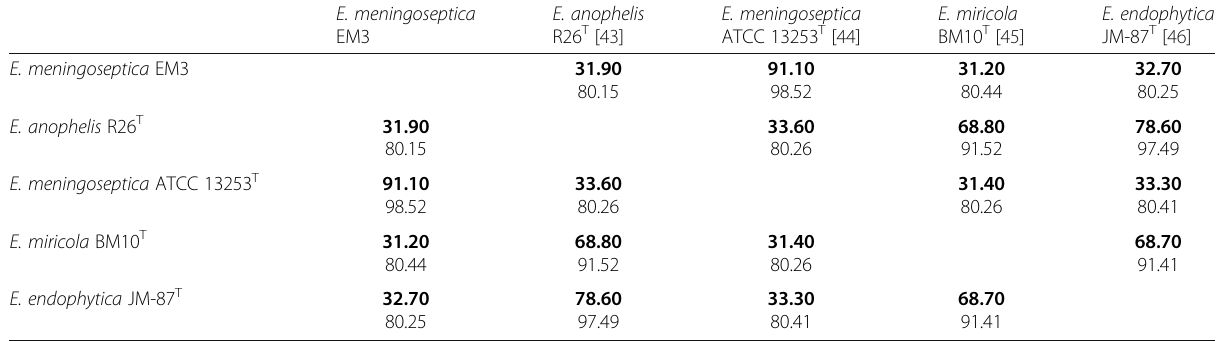
Table 2 Percentage of in silico DNA-DNA hybridization (DDH) a and average nucleotide identities (ANI) b among the selected Elizabethkingia